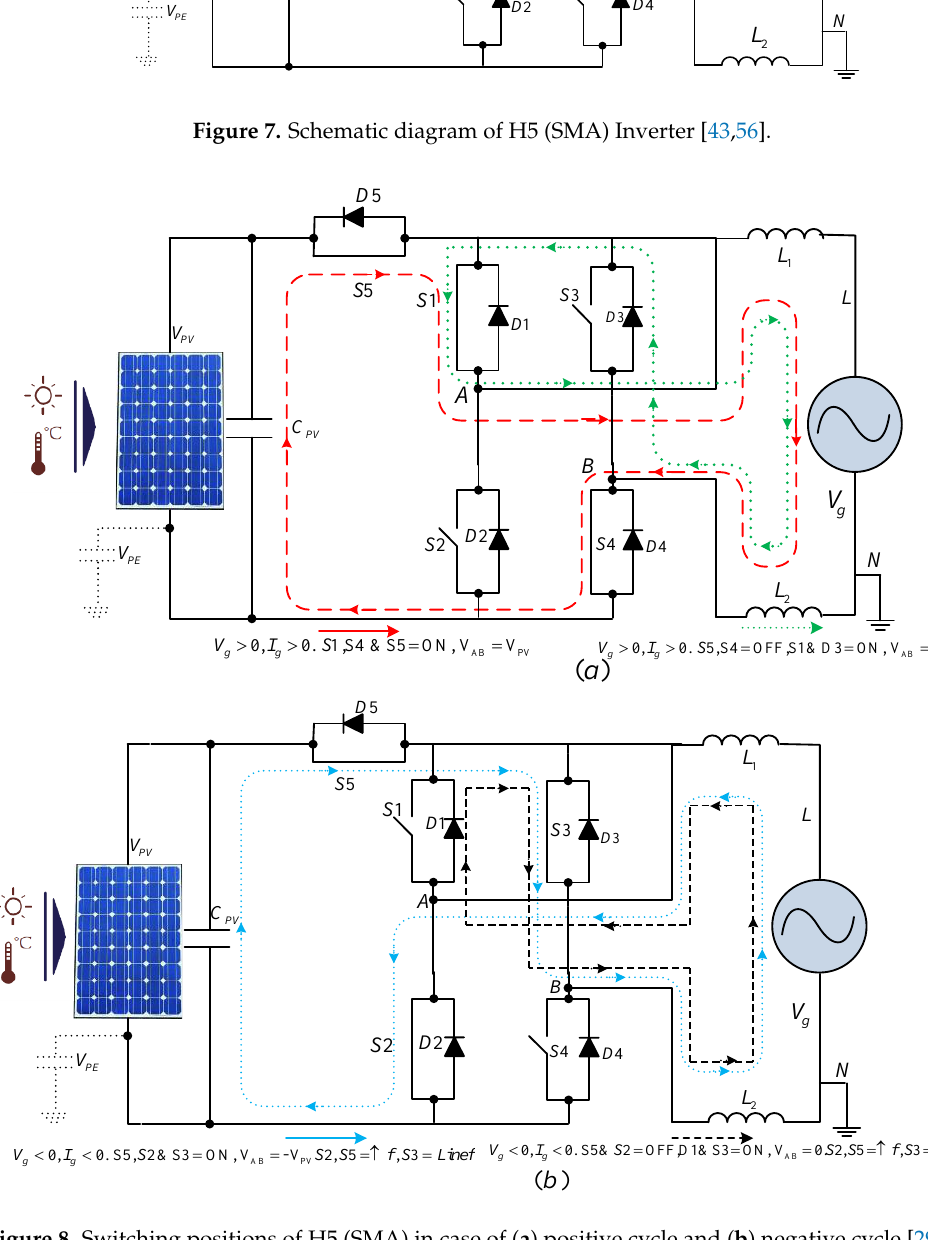
Figure 8. Switching positions of H5 (SMA) in case of ( a ) positive cycle and ( b ) negative cycle [29,30].